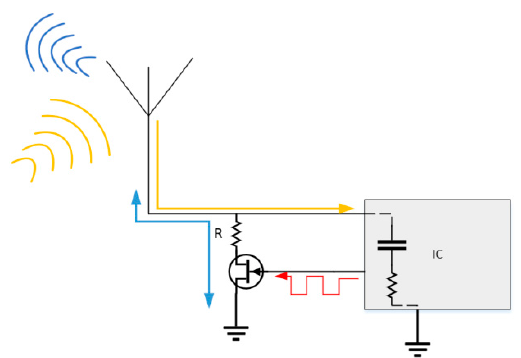
Figure 1. Classic Load Modulation Circuit.